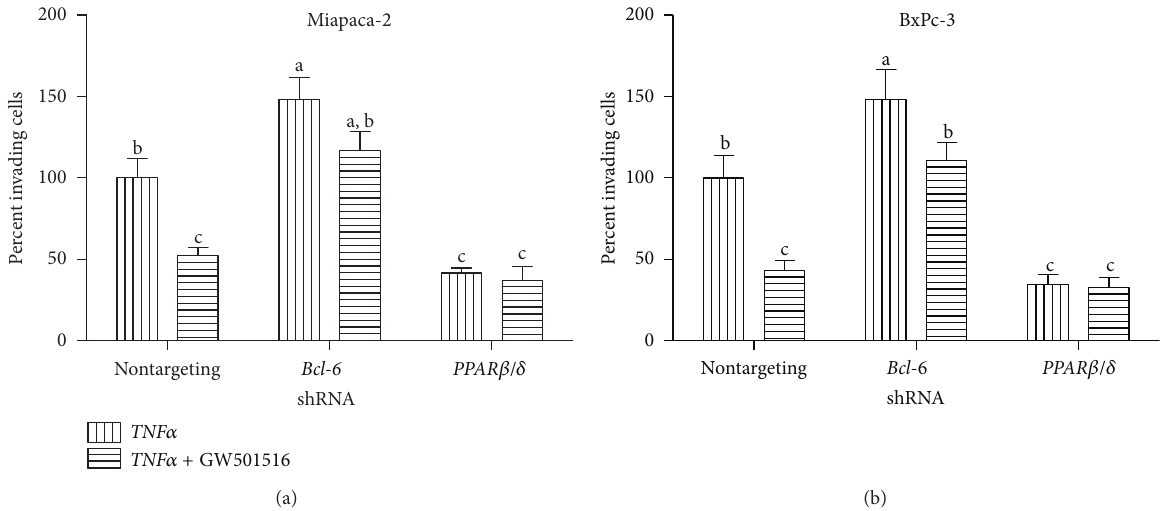
Figure 4: GW501516 treatment reduces 𝑇𝑁𝐹𝛼 -stimulated Miapaca-2 and BxPc-3 cell invasion through a basement membrane. Human pancreatic cancer cells were transiently infected with the indicated shRNAs and stimulated with human 𝑇𝑁𝐹𝛼 with or without GW501516. Cells were allowed to invade a basement membrane overnight, and relative invasion was quantified using the CytoSelect 96-well cell invasion assay with fluorometric readings at 480 nm / 520 nm. GW501516 treatment inhibits the invasion of the COX-2 negative pancreatic cancer cell line Miapaca-2 (a) and the COX-2 positive pancreatic cancer cell line BxPc-3 (b) through a basement